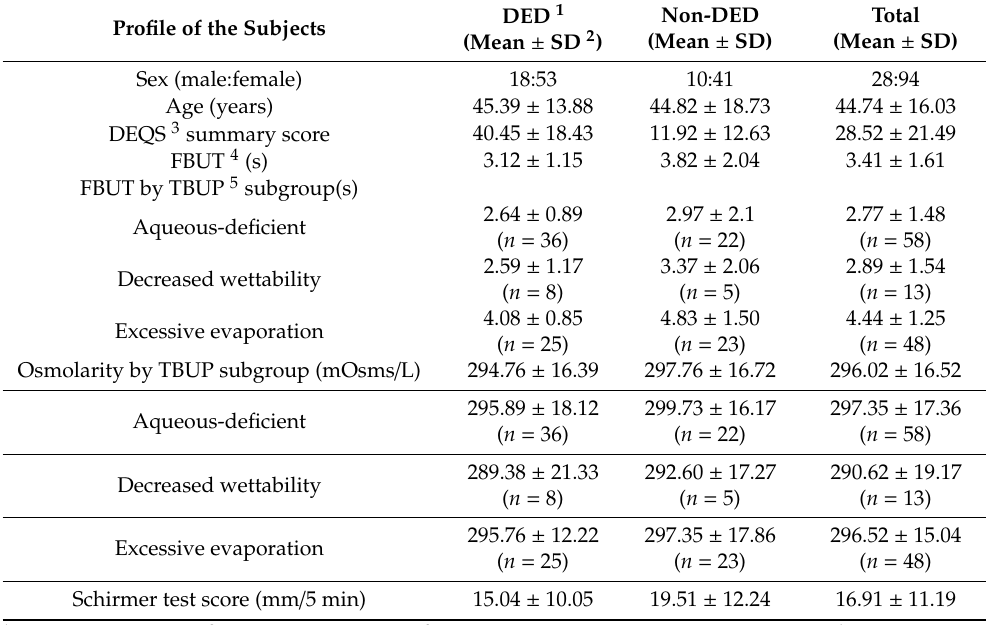
Table 1. Characteristics of the study